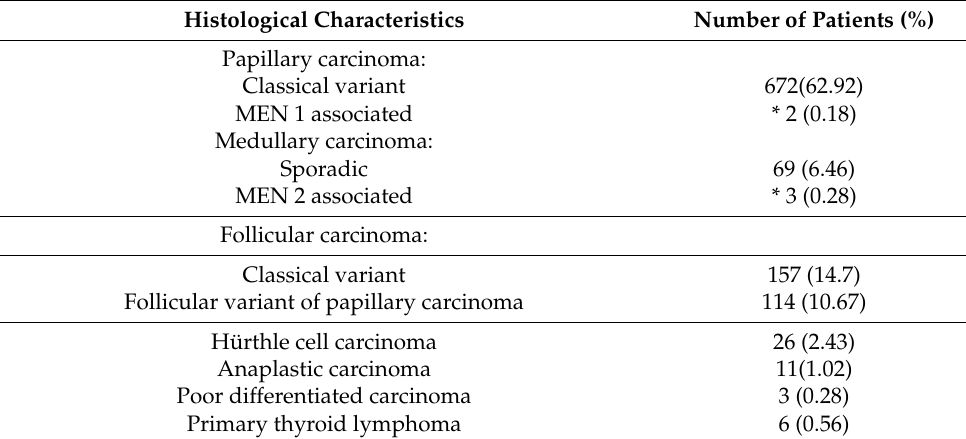
Table 1. Incidence of histopathological characteristics in 1068 patients.